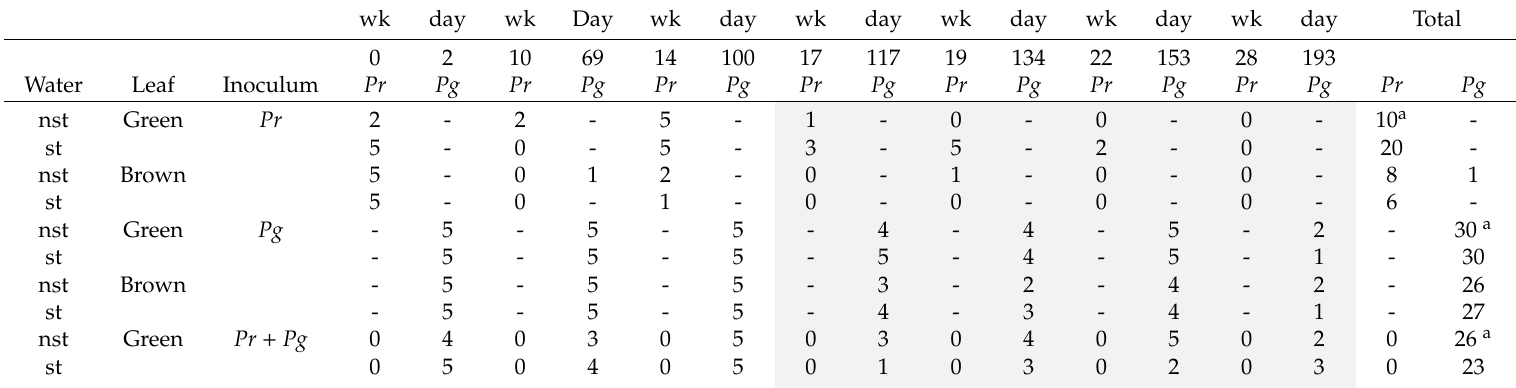
Table 2. Count of P. ramorum ( Pr ) and P. gonapodyides ( Pg ) recovery from single leaf disc baits deployed for three to seven days in a total of five microcosms per treatment (i.e., out of five possible colonization events per sampling, 35 total. Dash indicates not inoculated and not recovered) in the second experiment where green and brown leaves were maintained in separate microcosms with either sterile (st) or non-sterile (nst) stream water added.. Grey shading indicates results from after all leaves had been removed from the microcosms (112